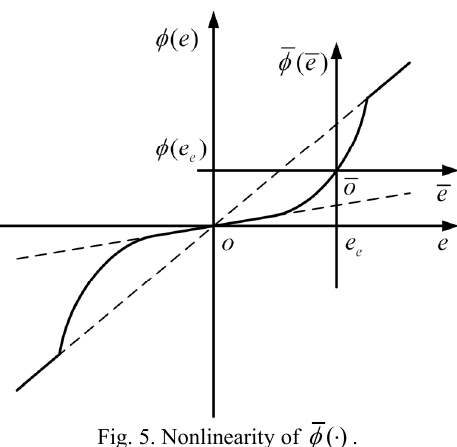
Fig. 5. Nonlinearity of ( ) φ ⋅